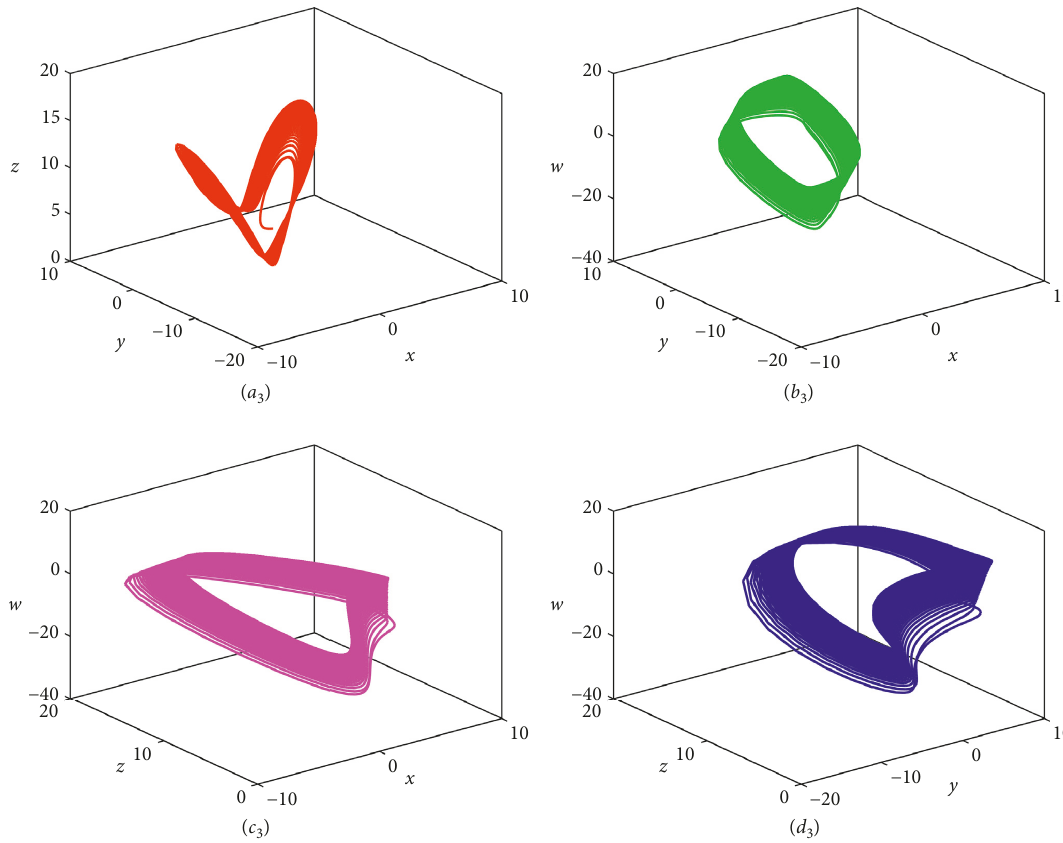
) on x − y − z plane; ( b 3